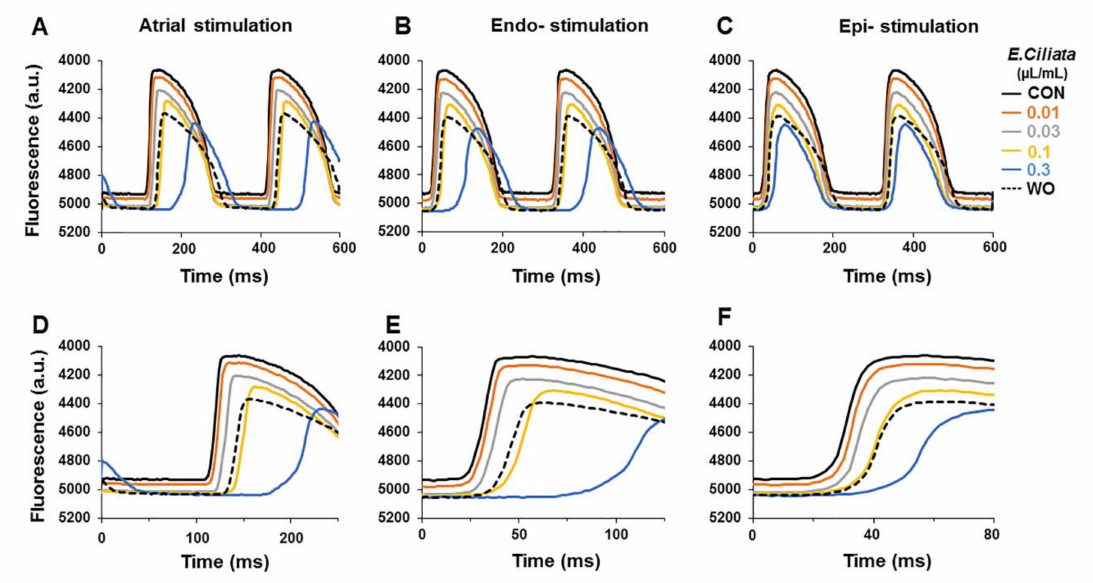
Figure 5. E. ciliata e ff ects on optically recorded APs using voltage-sensitive fluorescent dye. Atrial / endo- / epi-cardial pacing with a 300 ms period was applied. ( A – C ) Superimposition of the optical APs (OAPs) and ( D – F ) their upstrokes on an expanded scale obtained in the control (CON; black) and after application of 0.01, 0.03, 0.1, and 0.3 µ L / mL concentrations the E. ciliata (orange, grey, yellow and blue, respectively), followed by a washout period (WO; dotted). Notice a delay in activation time with 0.3 µ L / mL concentration of the E. ciliata , and reversibility. Zero time indicates the time of